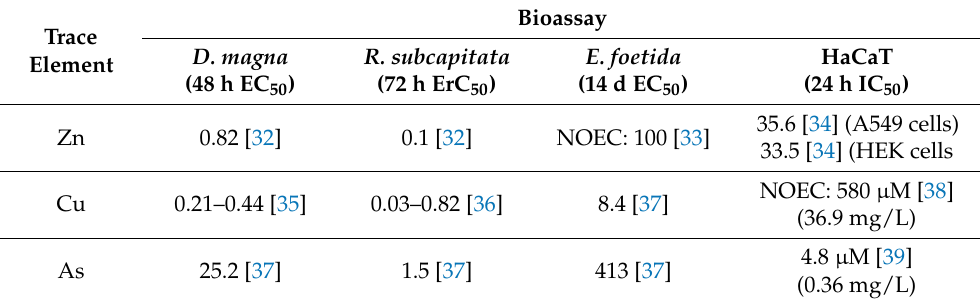
Table 5. EC 50 values for Zinc, Copper and Arsenic in D. magna (mg/L), R. subcapitata (mg/L), E.